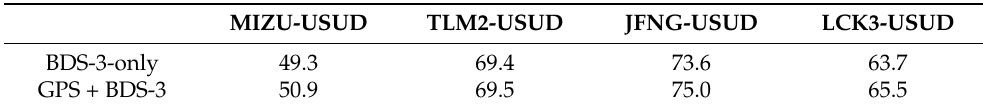
Figure 11. STD of difference between B2b-RTPPP solutions and GBM-PPP solutions. The reductions of the C and GC B2b-RTPPP solutions with DCB compared with that without DCB at the STDs of the clock difference are illustrated in Table 5. For the C B2b- RTPPP, the reductions of STD ranged from 49.3% to 73.6%, with a mean reduction of 64%. The reductions of GC B2b-RTPPP were almost the same as that of GC B2b-RTPPP. Therefore, the DCB had a great impact on the time transfer, which validated our previous findings. In addition, compared with G B2b-RTPPP, the reductions of the C and GC B2b-RTPPP solutions with DCB ranged from 69.0–80.1% and 70.6–81.3%, with a mean reduction of 76.7% and 77.7%, respectively. For the B2b-RTPPP without DCB, STDs were reduced by at least 14.5%, and by a maximum of 60.1% for C B2b-RTPPP. STDs were reduced by at least 14.6%, and by a maximum of 60.4% for GC B2b-RTPPP. Thus, the C and GC B2b-RTPPP performed better than the G B2b-RTPPP. Table 5. The reduction of C and GC B2b-RTPPP solutions with DCB compared to that without DCB at STD values for clock difference